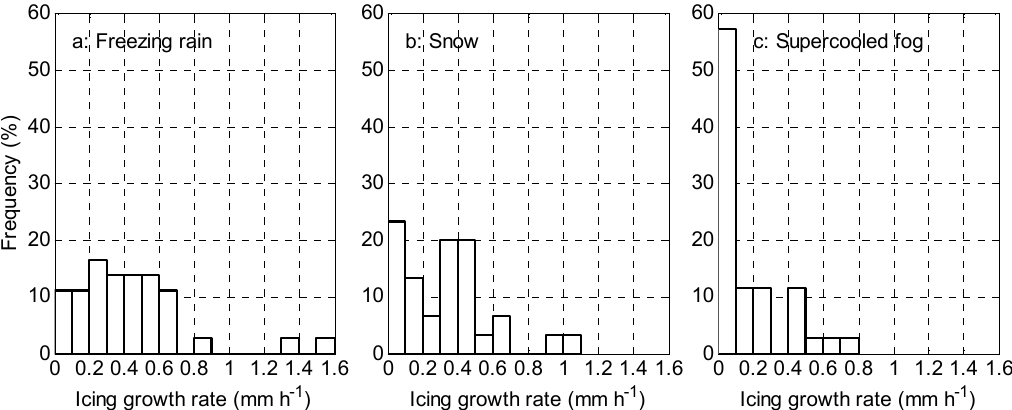
Figure 4. Frequency distributions of the icing growth rates in ( a ) freezing rain, ( b ) snow, and ( c ) supercooled fog.